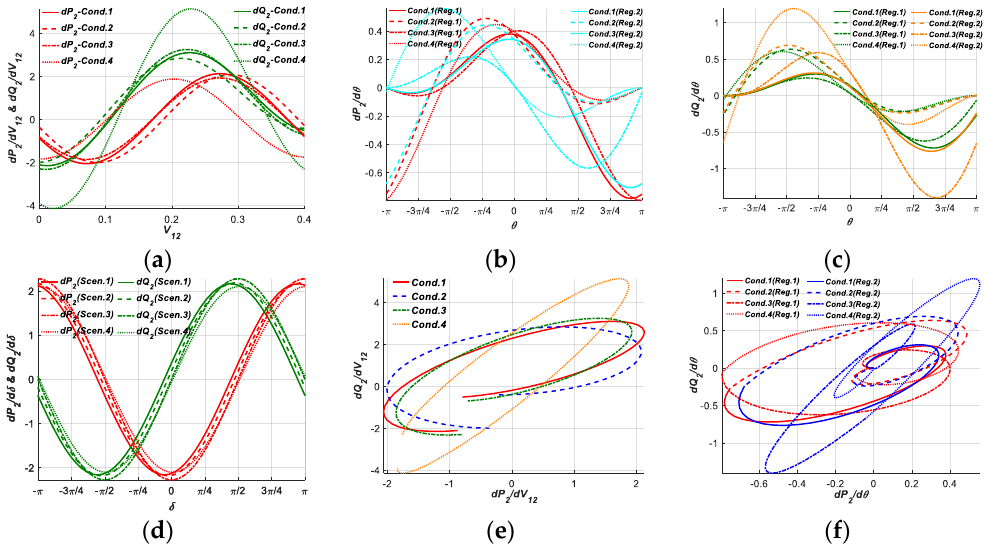
Figure 7. Curves of PFG to each CIV at SCP3 in planes: ( a ) Curves of the PFG to CIV1; ( b ) Curves of the APFG to CIV2. ( c ) Curves of the RPFG to CIV2; ( d ) Curves of APFG and RPFG to CIV3; ( e ) Curves of APFG against RPFG to CIV1; ( f ) Curves of APFG against RPFG to CIV2.